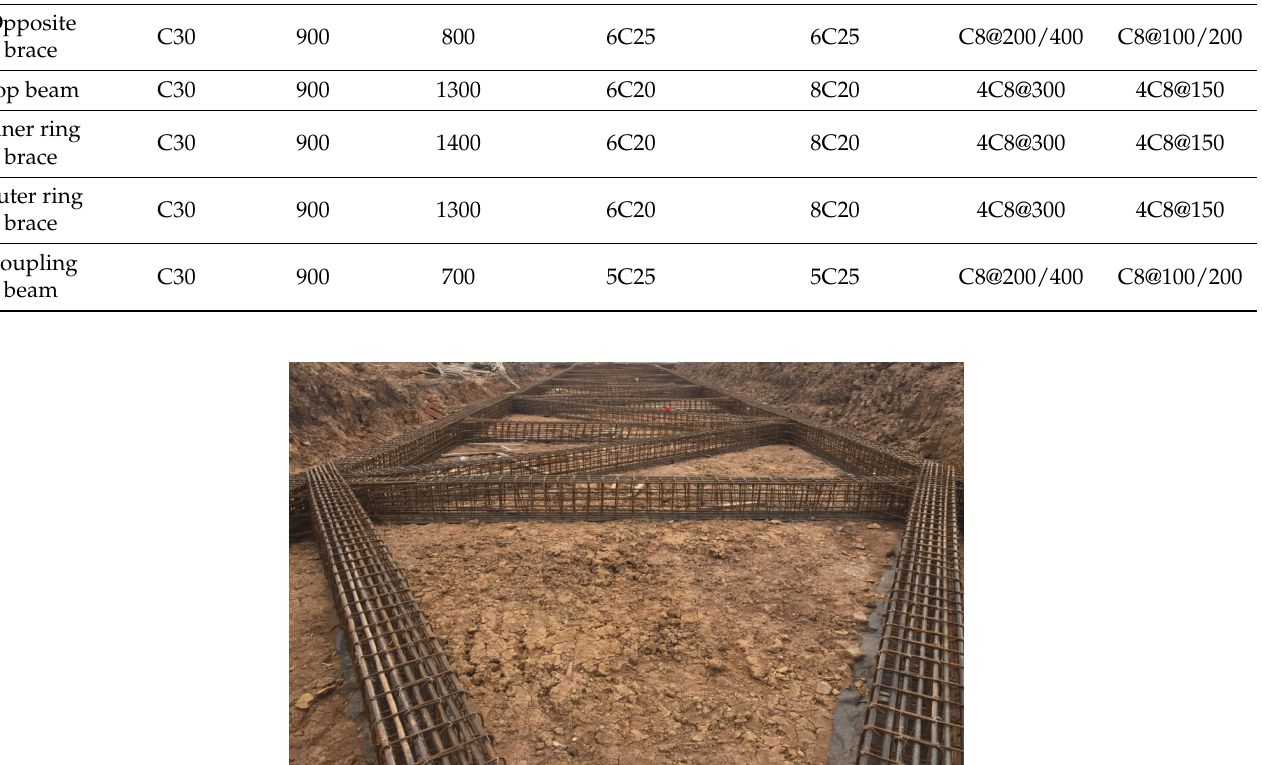
Table 2. Sectional parameters of the braces.